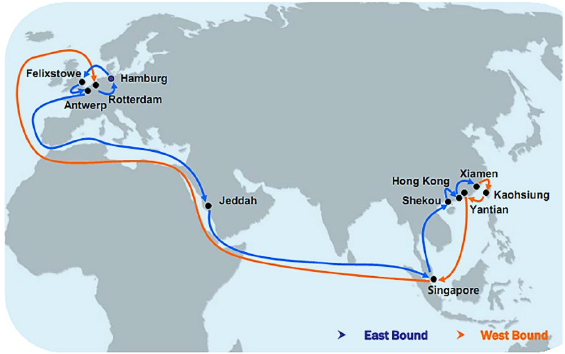
Figure 3. ETE service with intermediate regions